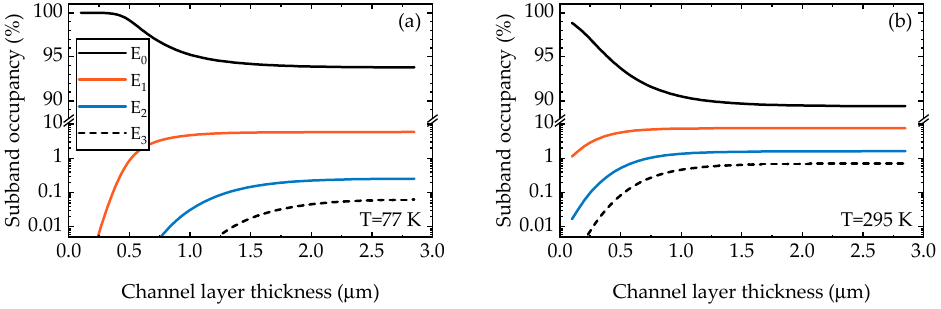
Figure 4. The calculated sub-band occupancies of the four lowest sub-bands at 77 K ( a ) and 295 K ( b ).